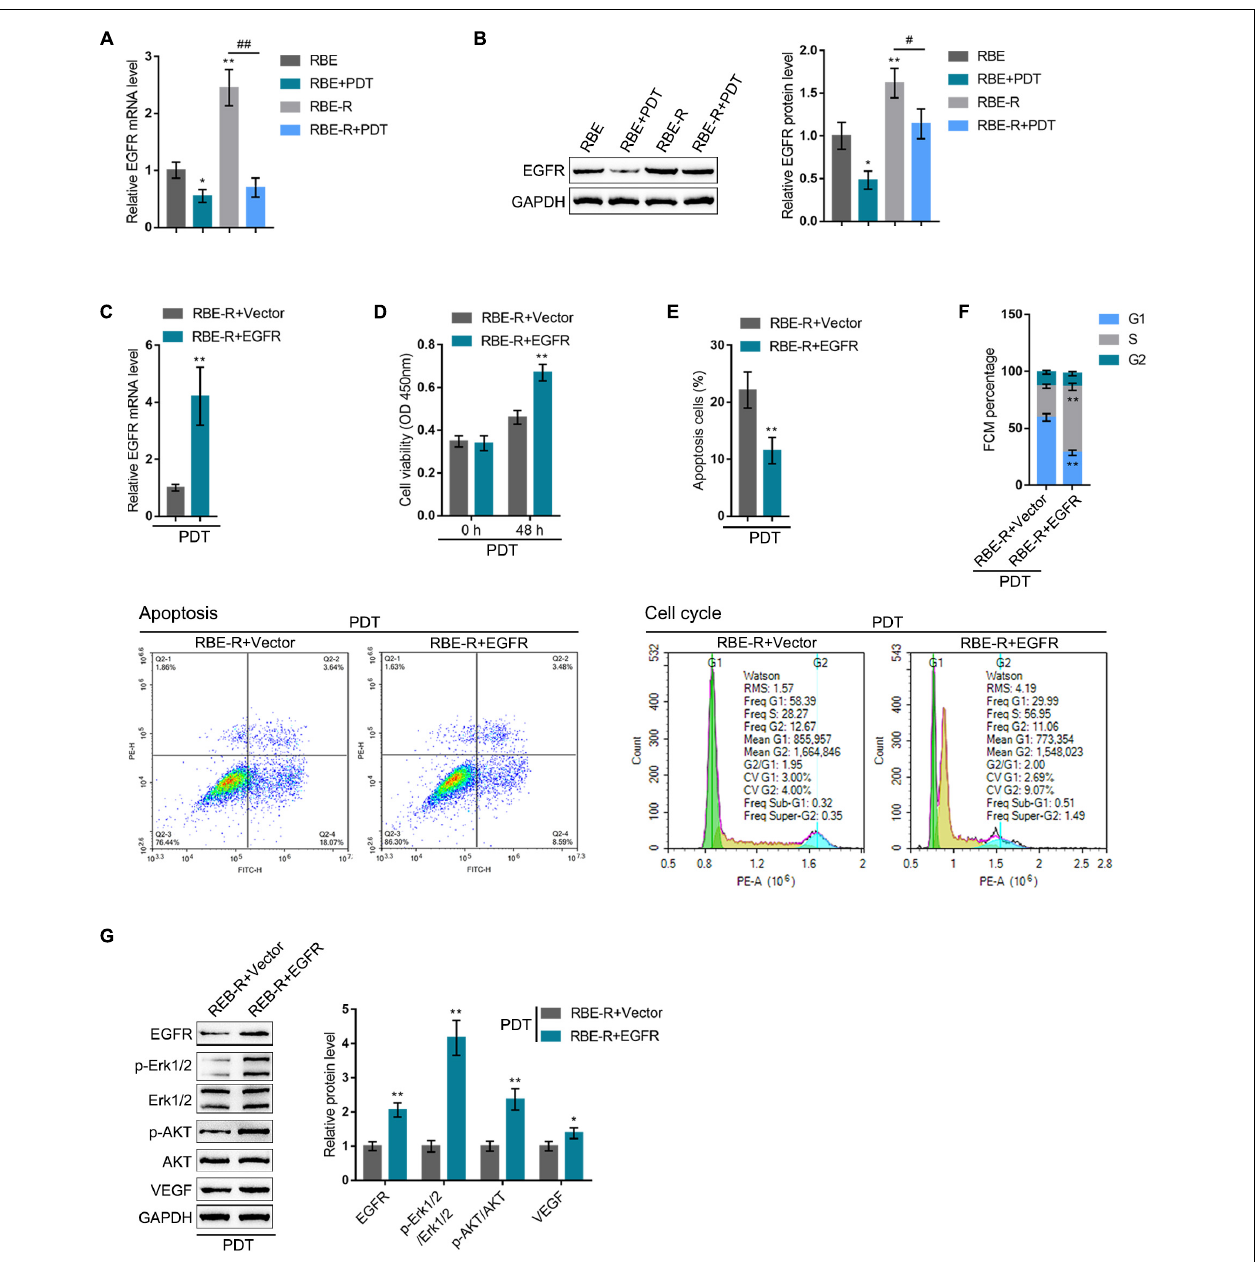
FIGURE 5 | EGFR might participate in PDT reversing cholangiocarcinoma gemcitabine resistance. RBE or gemcitabine-resistant RBE-R cells were treated or non-treated with PDT and examined for EGFR mRNA expression by real-time qPCR (A) and the protein levels of EGFR by Immunoblotting (B) . (C) EGFR overexpression was achieved in RBE-R cells by transfecting EGFR-overexpressing vector (EGFR). The transfection efficiency was verified using real-time qPCR. Then, RBE-R cells were transfected with EGFR or empty vector (negative control), exposed to PDT treatment, and examined for cell viability by MTT assay (D) ; cell apoptosis by Flow cytometry (E) ; cell cycle distribution by Flow cytometry (F) ; the protein levels of EGFR, Erk1/2, p-Erk1/2, Akt, p-Akt, and VEGF by Immunoblotting (G) . * P < 0.05, ** P < 0.01, # P < 0.05, ## P <